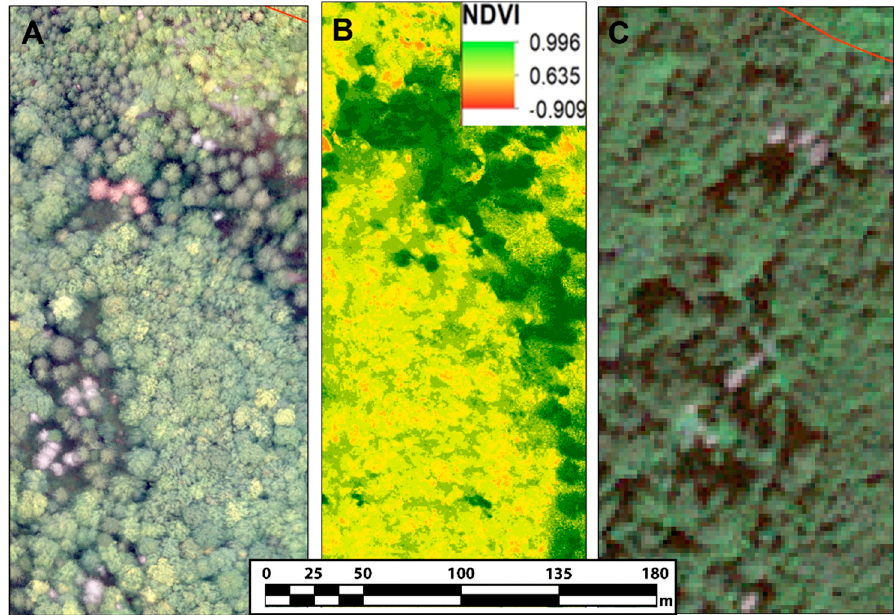
Figure 2. Comparison between the resolution of the images from UAV and satellite platform: ( A )—RGB orthophoto mosaic from UAV (7 cm/pixel); ( B )—NDVI from UAV multispectral images (20 cm/pixel); ( C )—RGB satellite image form EUSI archive (50 cm/pixel).